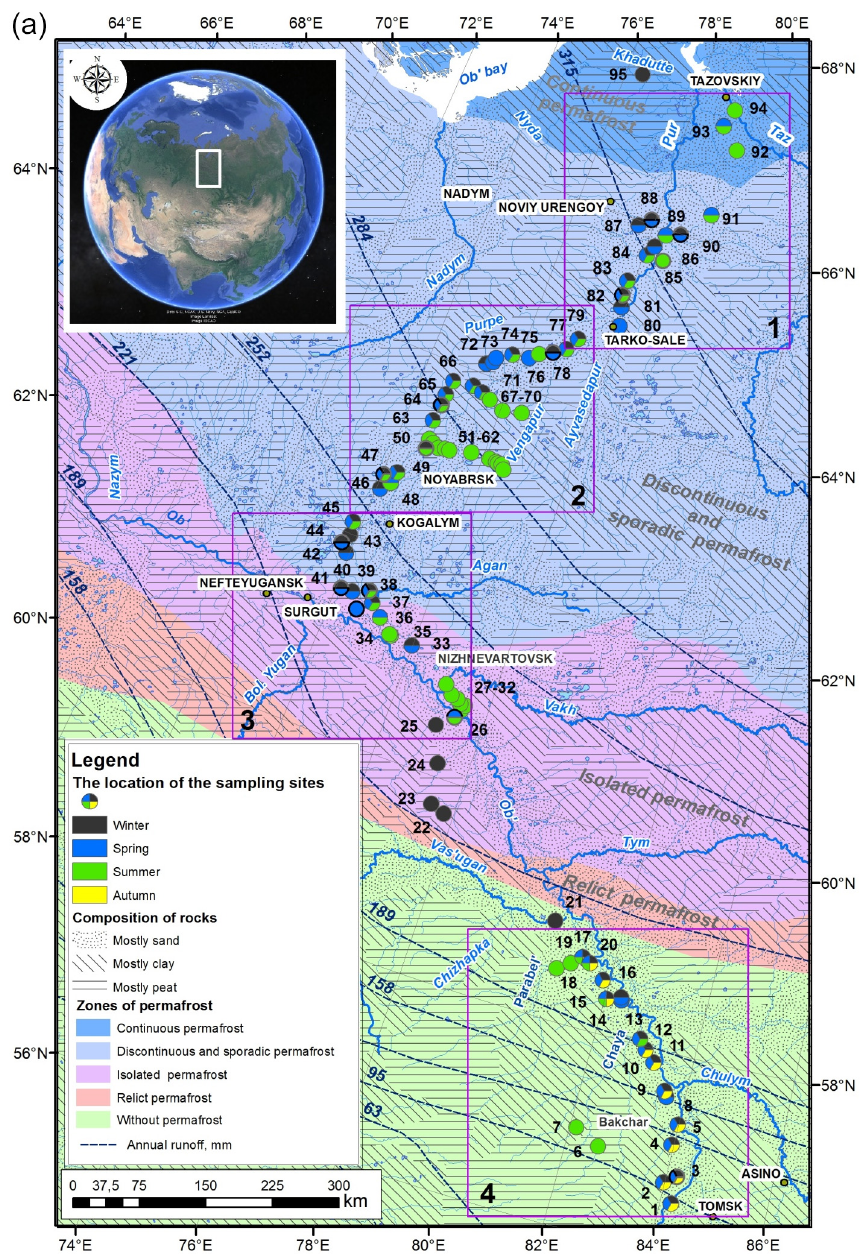
tistically significant ( H = 10 . 6, p = 0 . 014). Considering the full data set of all seasons and watershed sizes, we distin- guished three geographical zones in terms of the permafrost abundance: continuous, discontinuous and absent. For most river water parameters (pH, DIC, DOC, major anions and cations) the differences between three zones are significant (30 < H < 95, p level < 0.001). Si concentration exhibited lower but statistically significant differences between differ- ent zones ( H = 9 . 5, p = 0 . 0086).